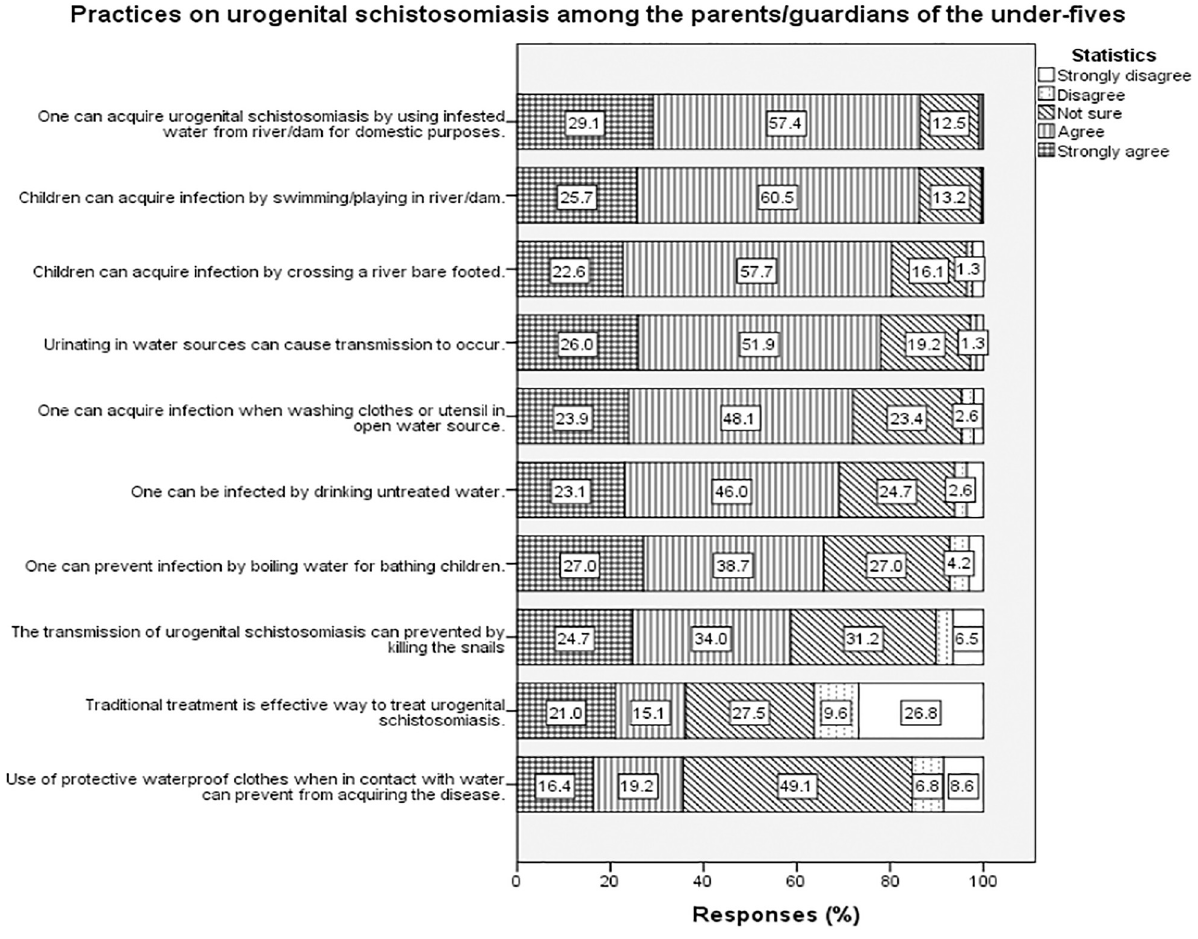
Fig 3. Practices on urogenital schistosomiasis among the parents/guardians of the under-fives.